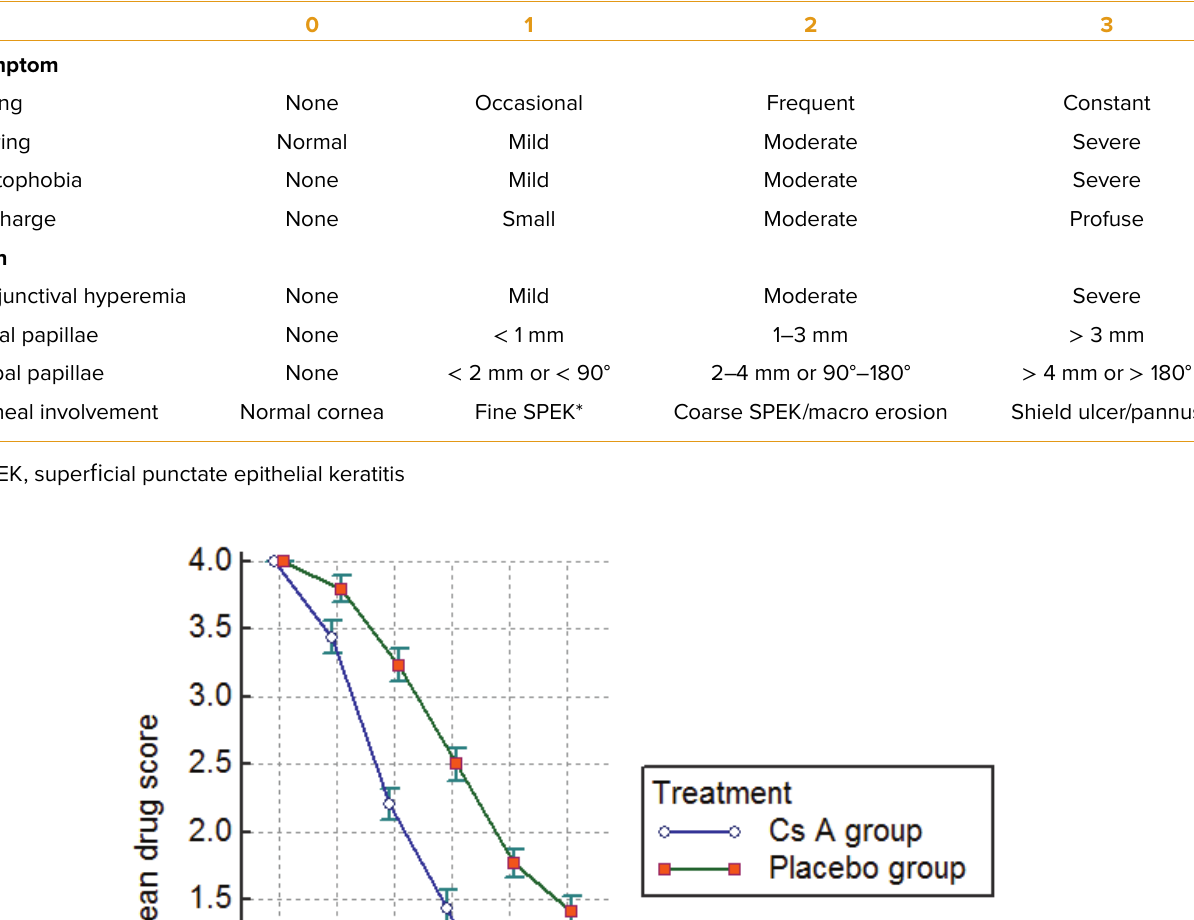
Table 1. The scoring method of symptoms and signs of vernal keratoconjunctivitis Variable